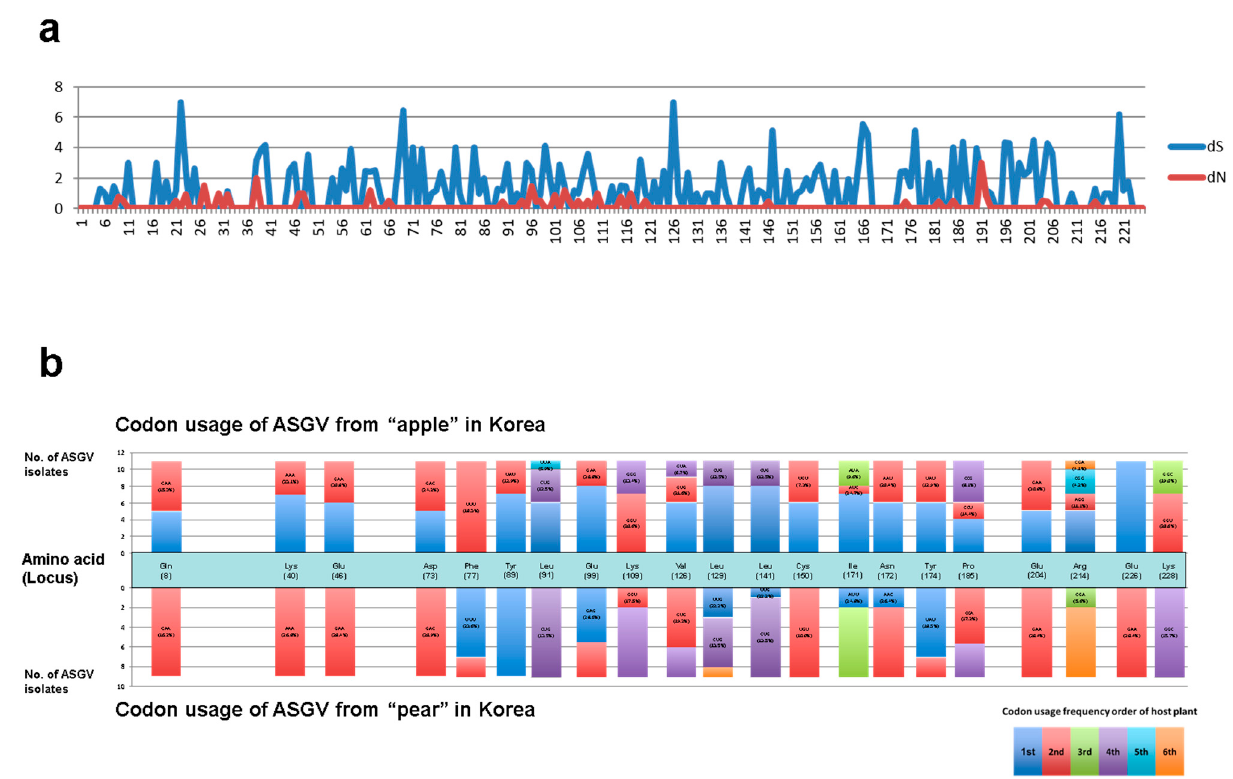
Figure 9. Codon usage analysis of Korean apple stem grooving virus (ASGV) coat protein gene. ( a ) Maximum likelihood analysis of natural selection codon-by-codon. The analysis involved 25 nucleotide sequences with 675 positions of ASGV codons. Most nucleotide substitutions were synonymous over the entire coat protein gene of Korean ASGV. ( b ) Analysis of ASGV codon usage at loci of synonymous substitutions compared with host preferred codon usage frequency. Substitutions of virus gene codons tended to follow the preferred codon usage of the isolated host.